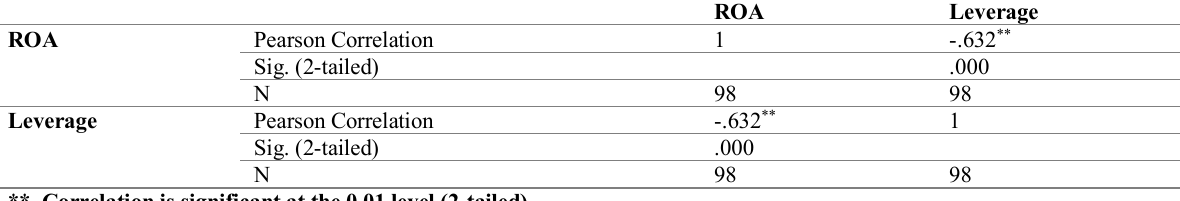
Table 6: Correlations between leverage and financial